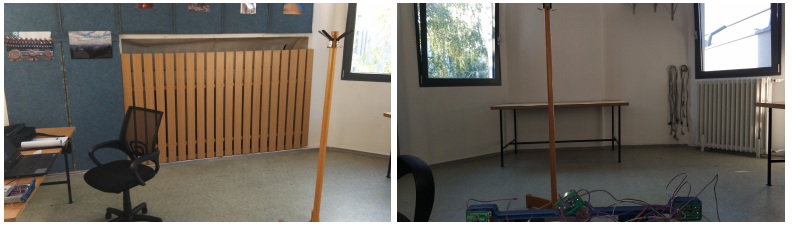
Figure 13. Indoor test No. 1.